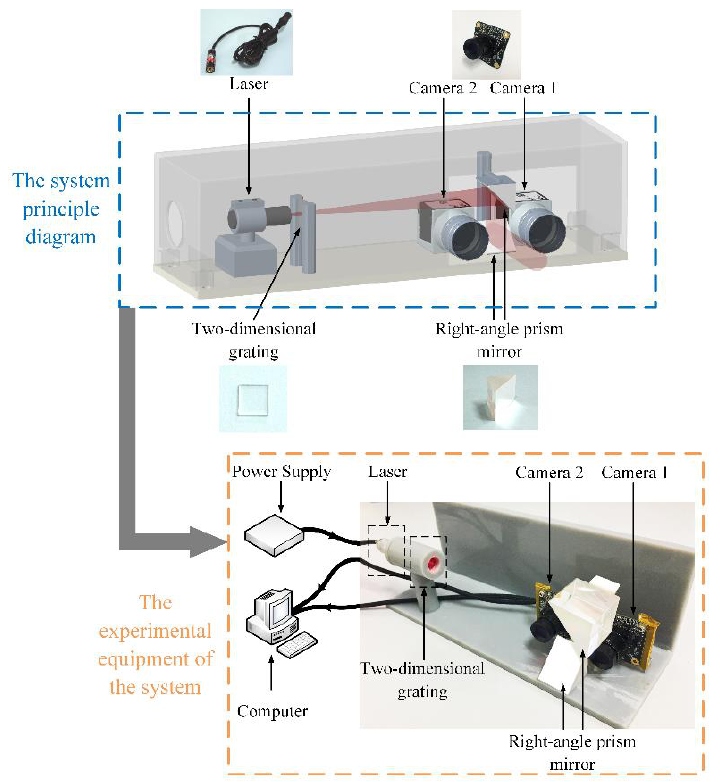
Figure 9. The experimental equipment of the 3D scanning system.